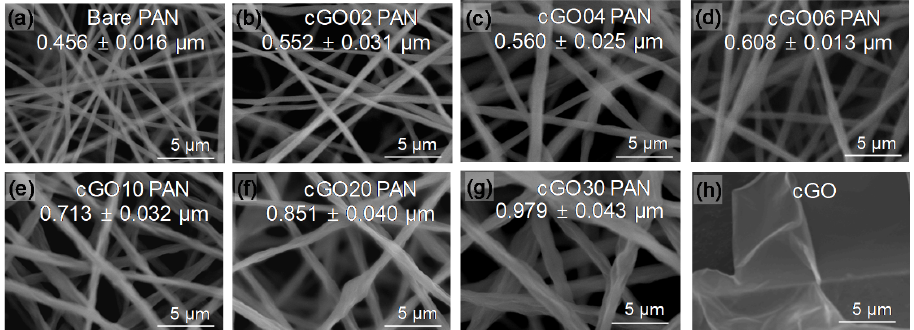
Figure 1. SEM images of ( a ) bare polyacrylonitrile (PAN), ( b – g ) cGO–PAN composite nanofiber membranes as a function of cGO content, and ( h ) cetyltrimethylammonium chloride (CTAC)-modified graphene oxide (cGO).